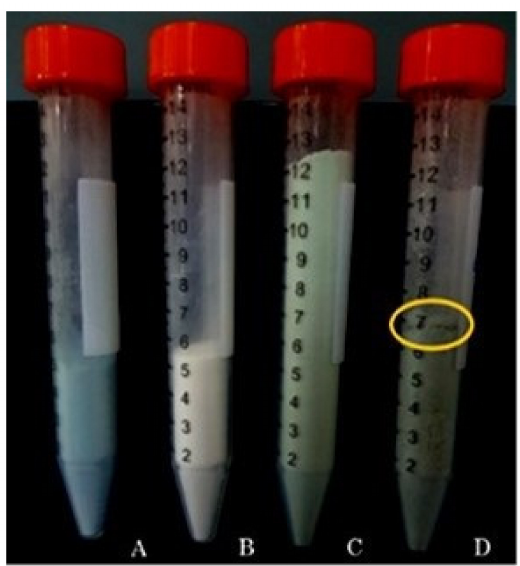
Figure 5. Mixing test on CM-HSE ( A ), Lactose / Mg Stearate 97:3 ( w / w ) ( B ), CM-HSE plus Lactose / Mg Stearate 97:3 ( w / w ) ( C ) and HSE plus Lactose / Mg Stearate 97:3 ( w / w ) ( D ) at T 120 (after 120 s of